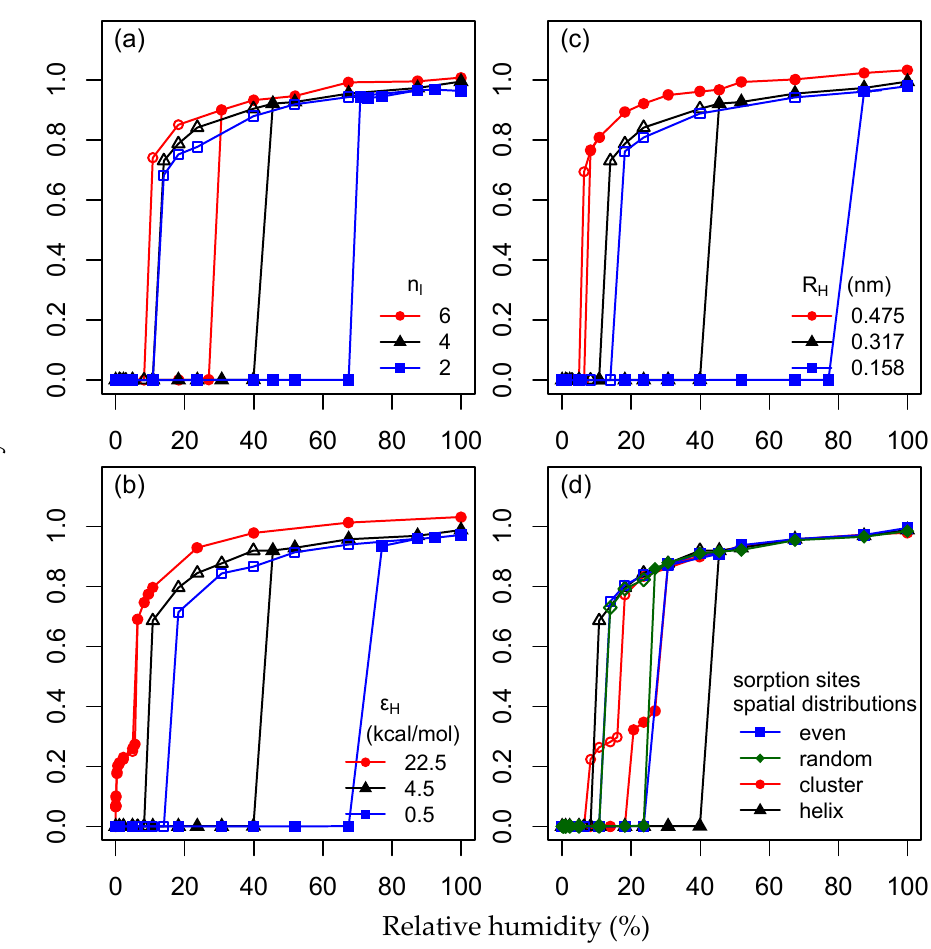
Figure 6. Simulated water sorption isotherms of 0.95 nm PW 2 pores at 25 ◦ C with different sorption sites ( a ) number, ( b ) strength, ( c ) interaction range and ( d ) spatial distributions. solid symbols, adsorption; open symbols, desorption.